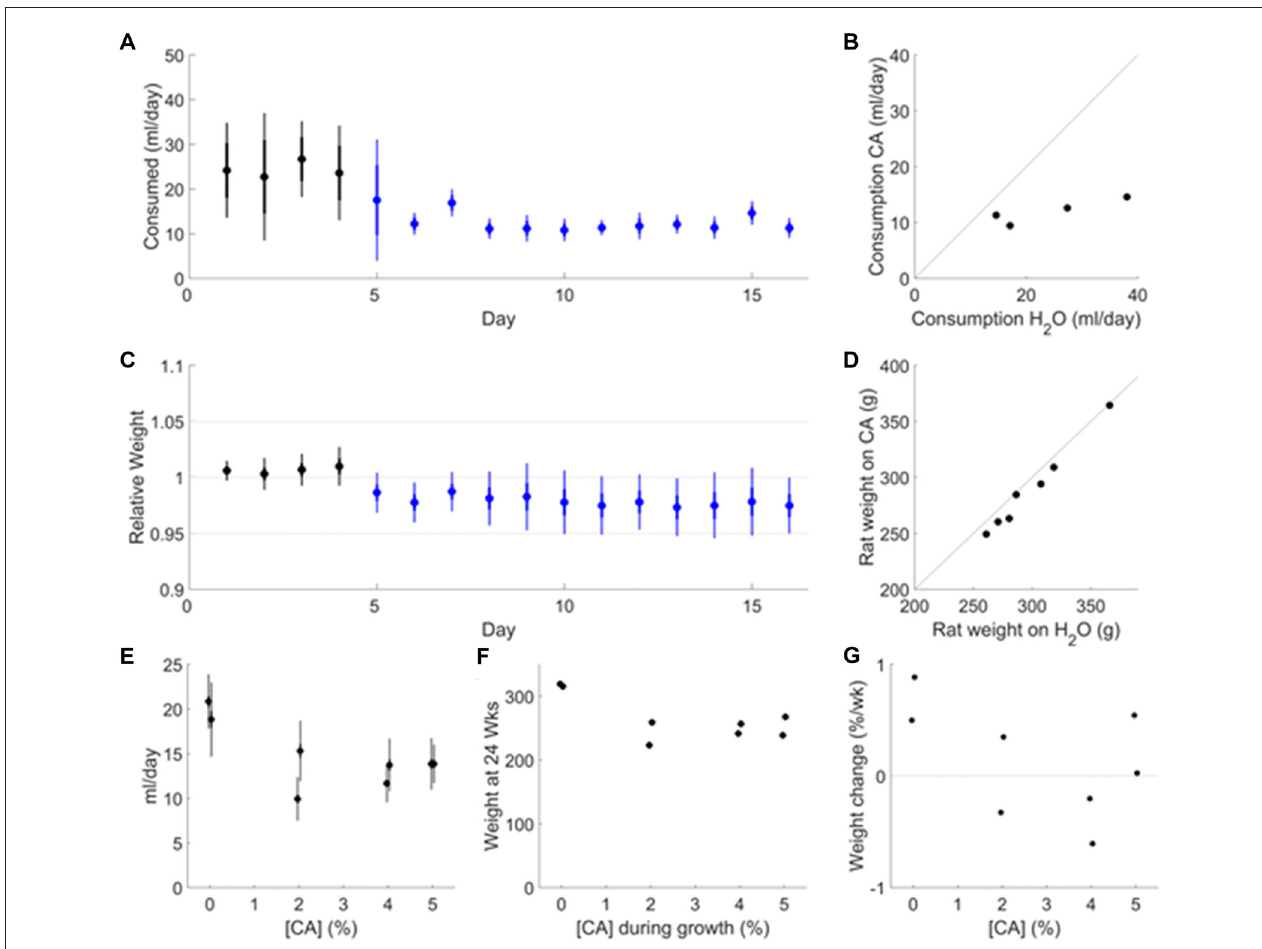
FIGURE 1 | Effect of citric acid (CA) adulteration on water consumption, weight maintenance and growth. (A) Fluid consumption of adult rats (age ∼ 12 months, N = 7) transitioning to 2% CA water after >2 weeks on plain water. Average consumption (ml per rat) is based on daily measurement of consumption per cage (pair housed). Data are shown for the last 5 days on plain water (black symbols) and for the first 12 days after switching to 2% CA (blue symbols). Error bars indicate SD (thin) and SEM (thick) over cages. (B) The average daily fluid consumption in each cage in the last 5 days on plain water is compared to the consumption in the same cage in the last 5 days on CA water. (C) Weight measured daily in N = 7 rats over the same time period shown in (A) . (D) The average weight of each rat in the last 5 days on plain water is compared to the last 5 days on CA water. (E) Daily water consumption as a function of citric acid concentration. Data are shown from a 21-day period around 6 months of age ( N = 2 rats per condition), after maintenance on CA since P28. Error bars indicate the SD (thin) or SEM (thick) over days. These values are consistent with the daily consumption from P72–P168 as measured per cage (pair housed; data not shown). (F) Adult weight at 24 weeks, as a function of citric acid concentration in ad lib water supply during growth. (G) Weight change of rats over the 21 days shown in (E) , expressed as a percentage of weight at the beginning of that period.